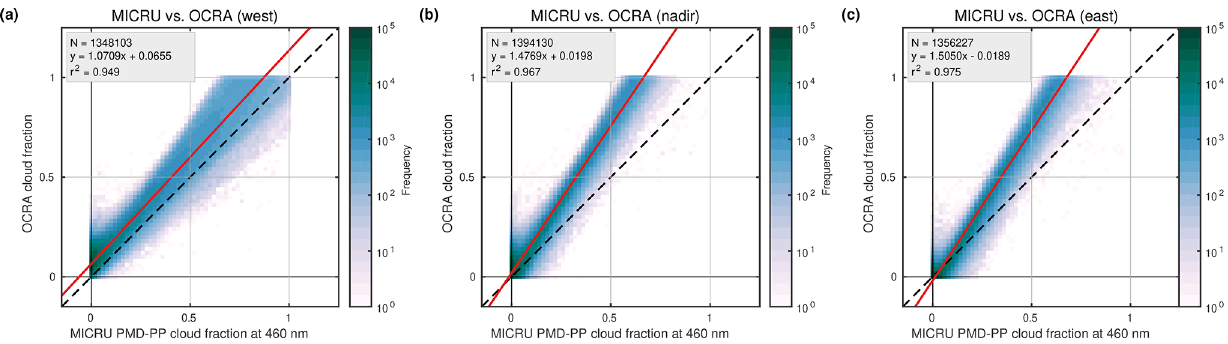
Figure 20. Same data as Fig. 18a but for different viewing angles: (a) west, (b) nadir, and (c) east. This comparison applies cropped